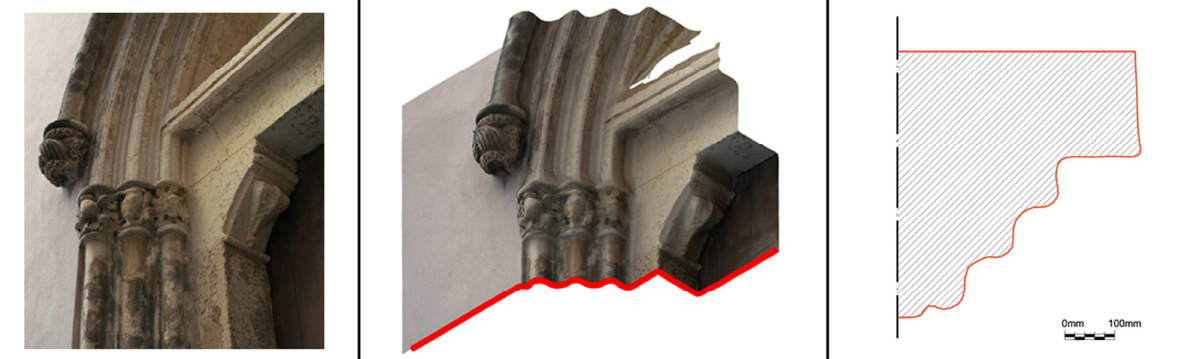
Figure 12. Portal of La Speranza, Cagliari: photographic image; model 123D Catch; reconstruction of the flat